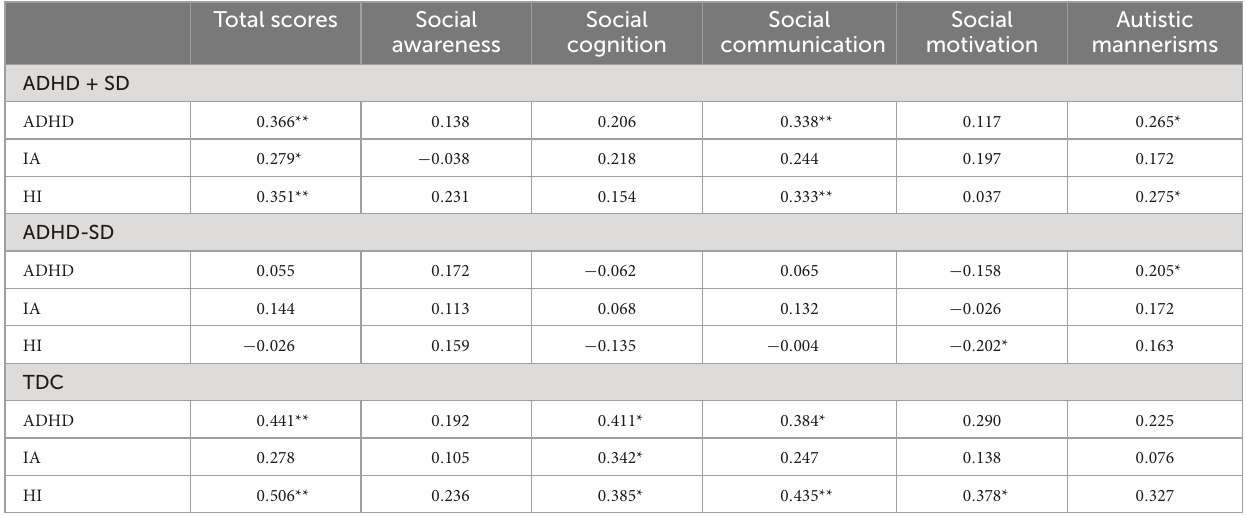
Thirty-seven participants in TDC group have the social responsiveness scale data. ADHD + SD, ADHD with social deficits subjects; ADHD-SD, ADHD without social deficits; TDC, typically developingcontrols. * P <0.05,** P <0.001. TABLE 2 The clinical characteristics between ADHD core symptoms and SRS-1 symptoms. Total scores Social